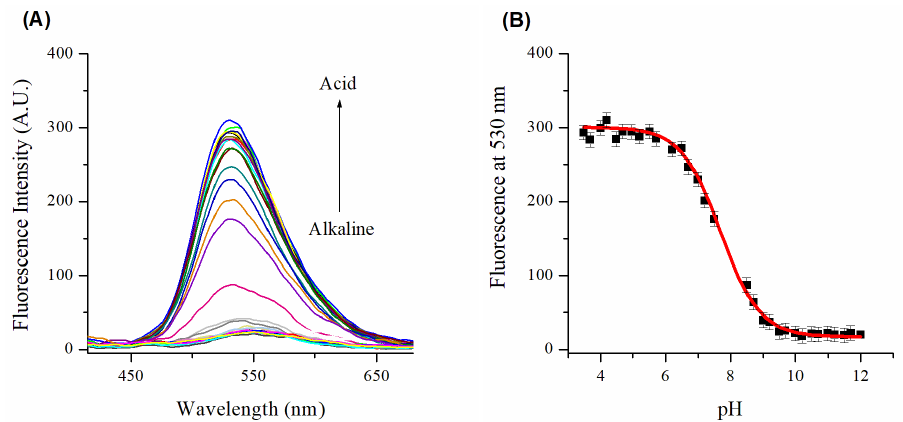
Figure 2. ( A ) Fluorescent spectra of probe 3 in 100% aqueous solution in a pH interval of 4 – 12 ( λ ex = 400 nm) and ( B ) pH titration plot of probe 3 fluorescence intensity at 530 nm.